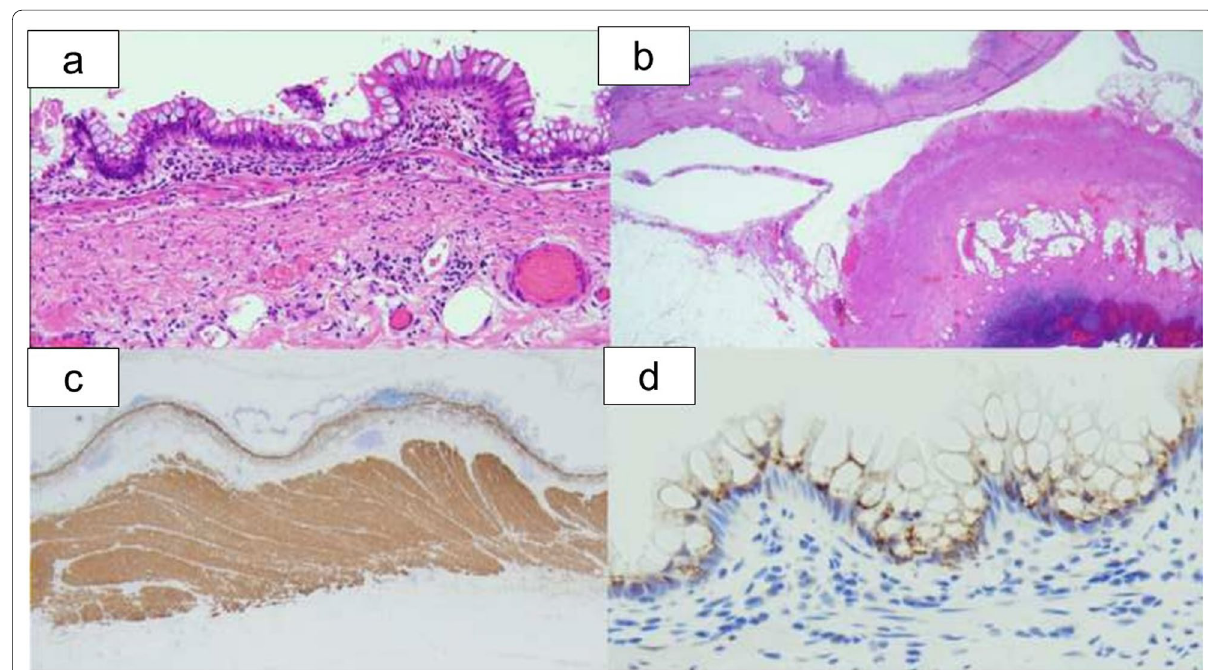
Fig. 5 Histological staining. Hematoxylin and eosin staining demonstrated smooth muscular layers in the cystic wall, consistent with the muscularis mucosae, submucosa and muscularis propria of the gastrointestinal tract, without the communication to the appendix ( a , b ). Desmin staining confirmed the intestinal wall structure of the muscularis mucosae and muscularis propria ( c ). The lining epithelial cells were positive for Mucin 2, indicating an intestinal-type glandular mucosa ( d )